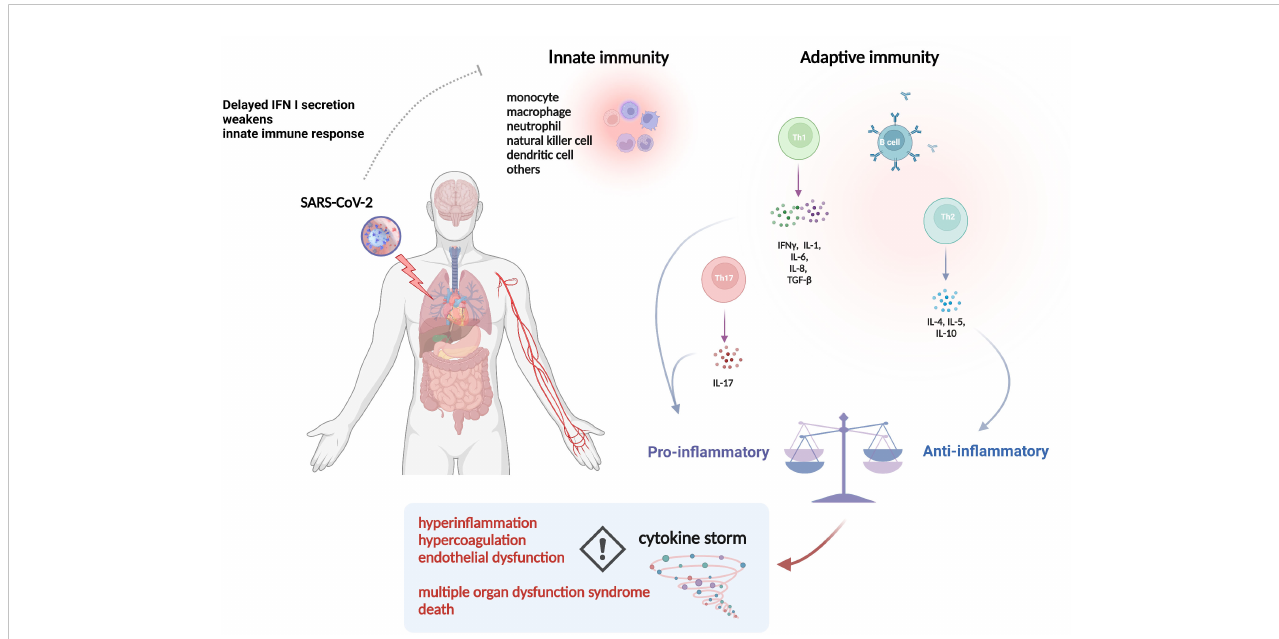
FIGURE 1 The pathophysiology of in fl ammatory events in COVID-19. Abbreviations: IFN, interferon; SARS-CoV-2, severe acute respiratory syndrome coronavirus 2; IL, interleukin; TGF, transforming growth factor. The picture was generated using BioRender